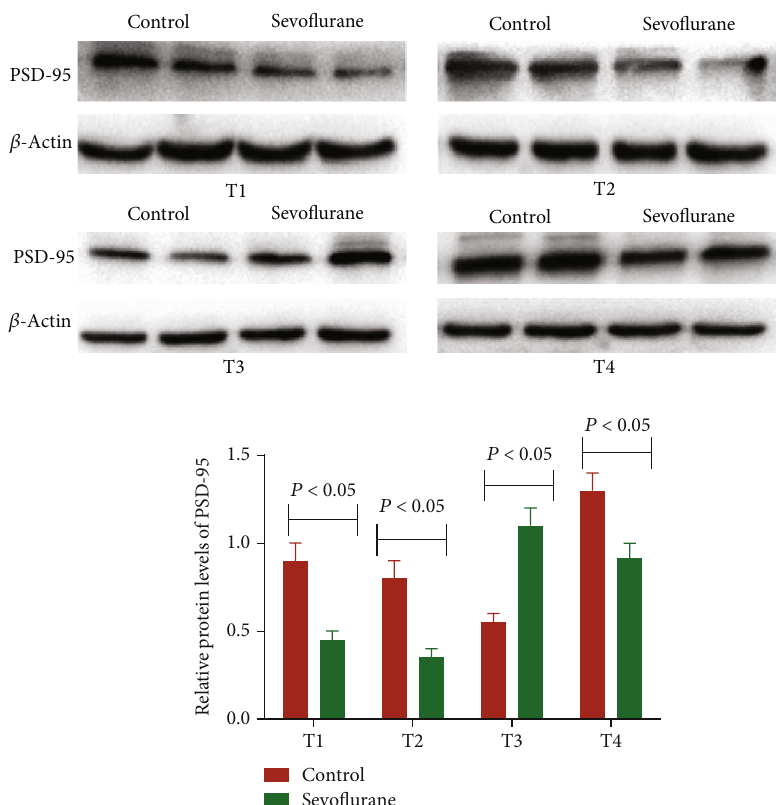
Figure 3: Western Blot analysis of relative protein levels of PSD-95. The mice were stopped for the inhalation of sevo fl urane or oxygen after 12h (T1), 24 h (T2), 48h (T3), and 72h (T4). n = 8 for each group, and the statistical di ff erence was signi fi cant if P < 0 : 05 vs. the control